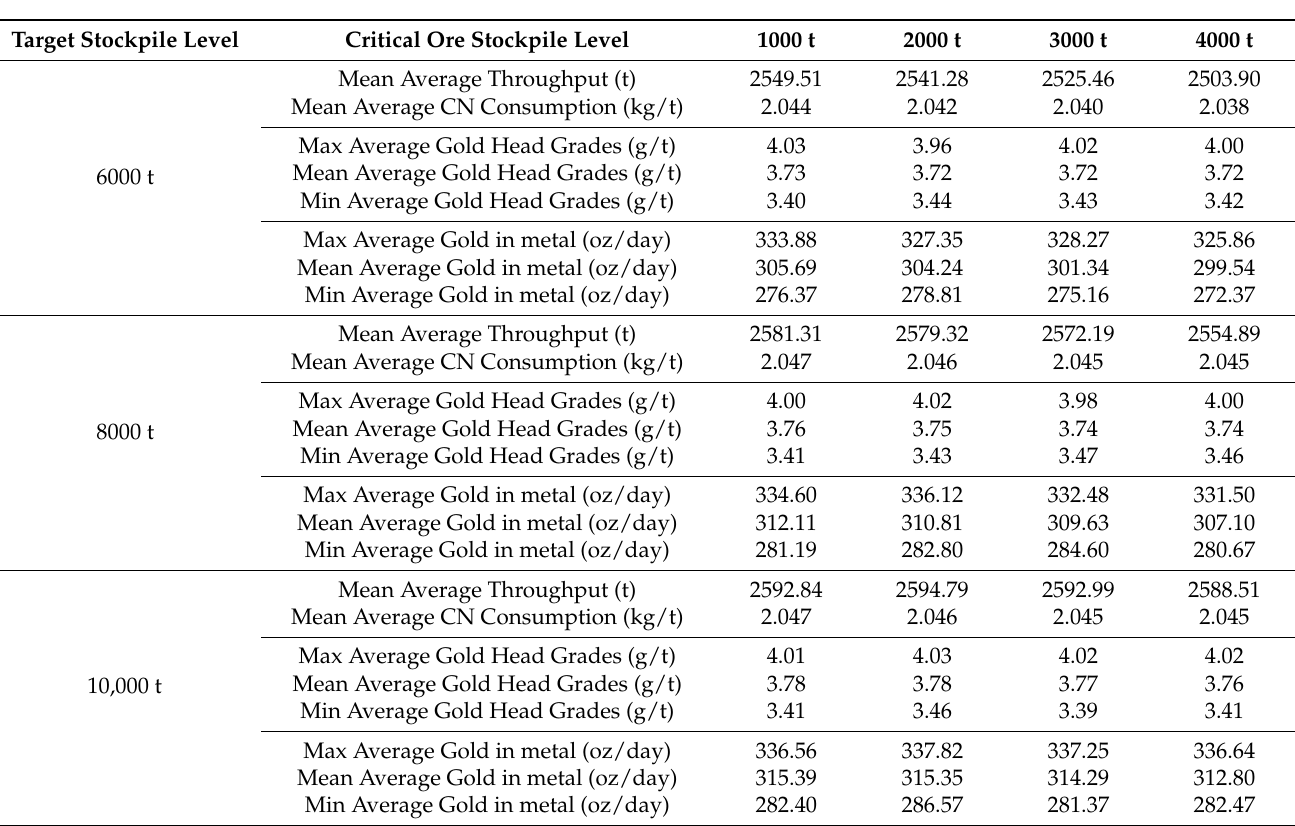
Table 8. Summary of discrete event simulation throughputs, cyanide consumption, and simulated gold